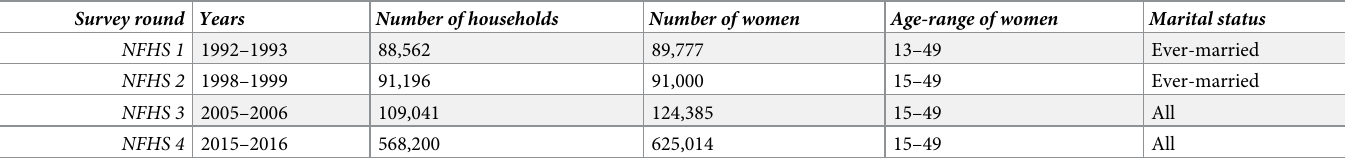
Table 1. Sample sizes and coverage of the four